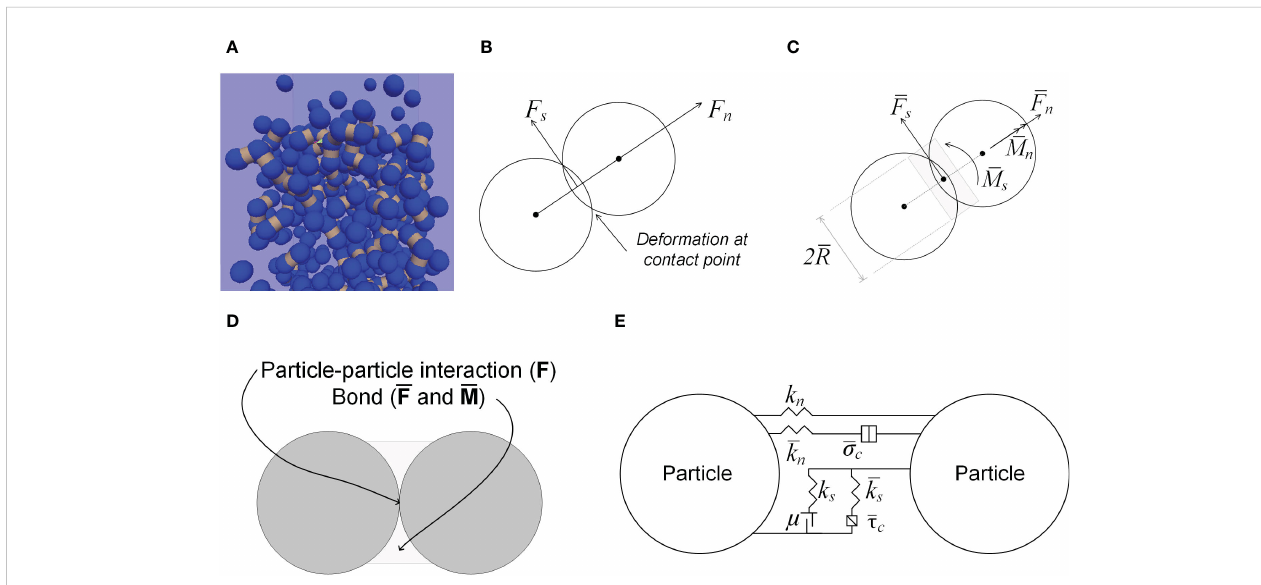
FIGURE 3 Modelling of growth medium. (A) Growth medium particles (blue) and bonds (dark yellow bands) between particles in contact. (B) Contact forces between particles. (C) Bond forces and bond radius. (D) Forces resulting from the particle-particle interaction. (E) Linear Parallel Contact Bond